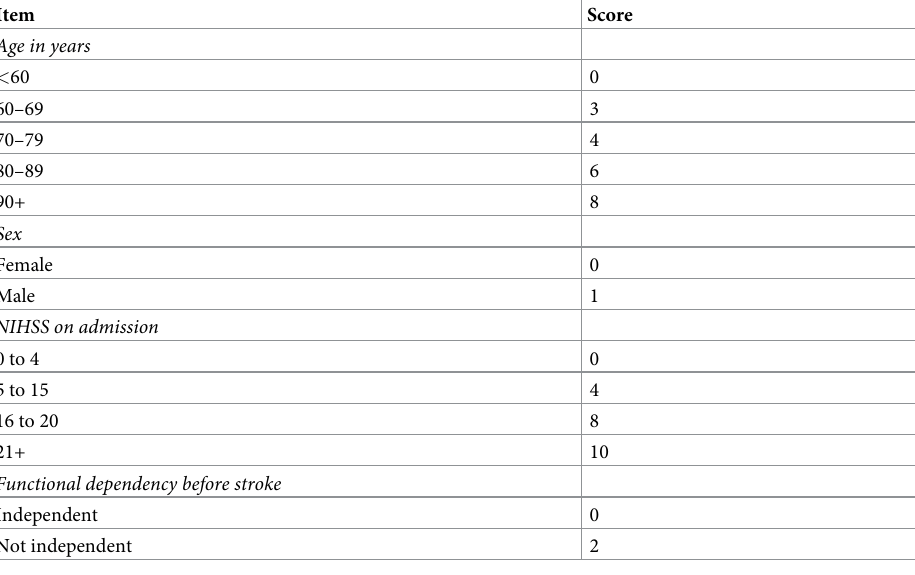
Table 1. Components and weightings of the ISAN score